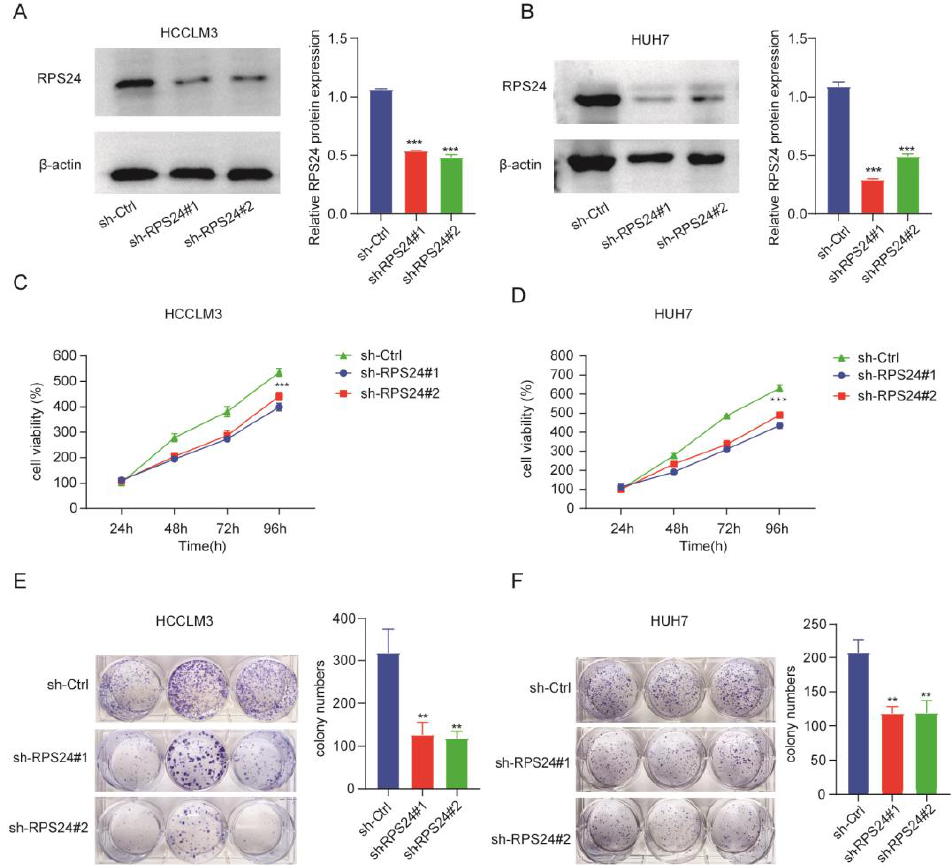
Figure 10. Knockdown of RPS24 impeded the cell proliferation of HCC. ( A , B ) The protein levels of RPS24 in the sh-RPS24 group and the sh-Ctrl group were tested using Western blot analysis. The CC-K8 assay displayed the effect of RPS24 knockdown on cell proliferation in the HCCLM3 ( C ) and HuH-7 ( D ) cell lines. ( E , F ) Colony formation capabilities of HCCLM3 ( E ) and HuH-7 ( F ) after RPS24 knockdown cells are shown. ** p < 0.01; *** p < 0.001.